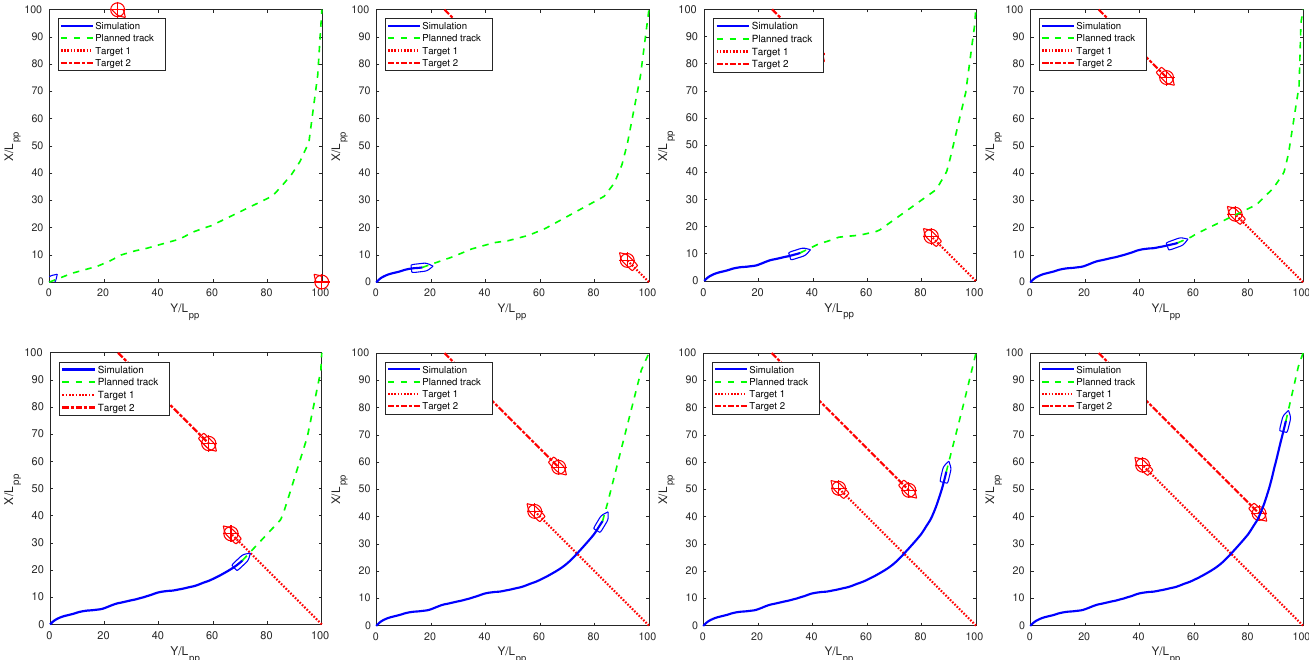
Figure 7. Scenario 1: simulation of a COLREG-compliant manoeuvre.